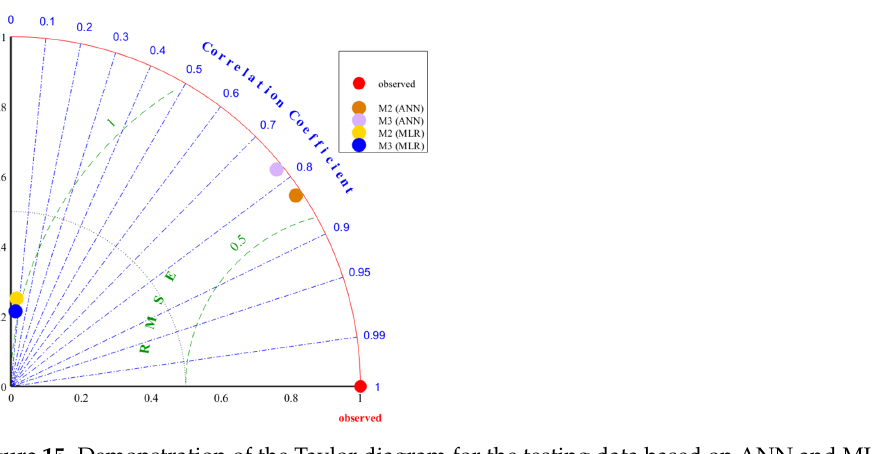
Figure 15. Demonstration of the Taylor diagram for the testing data based on ANN and MLR.